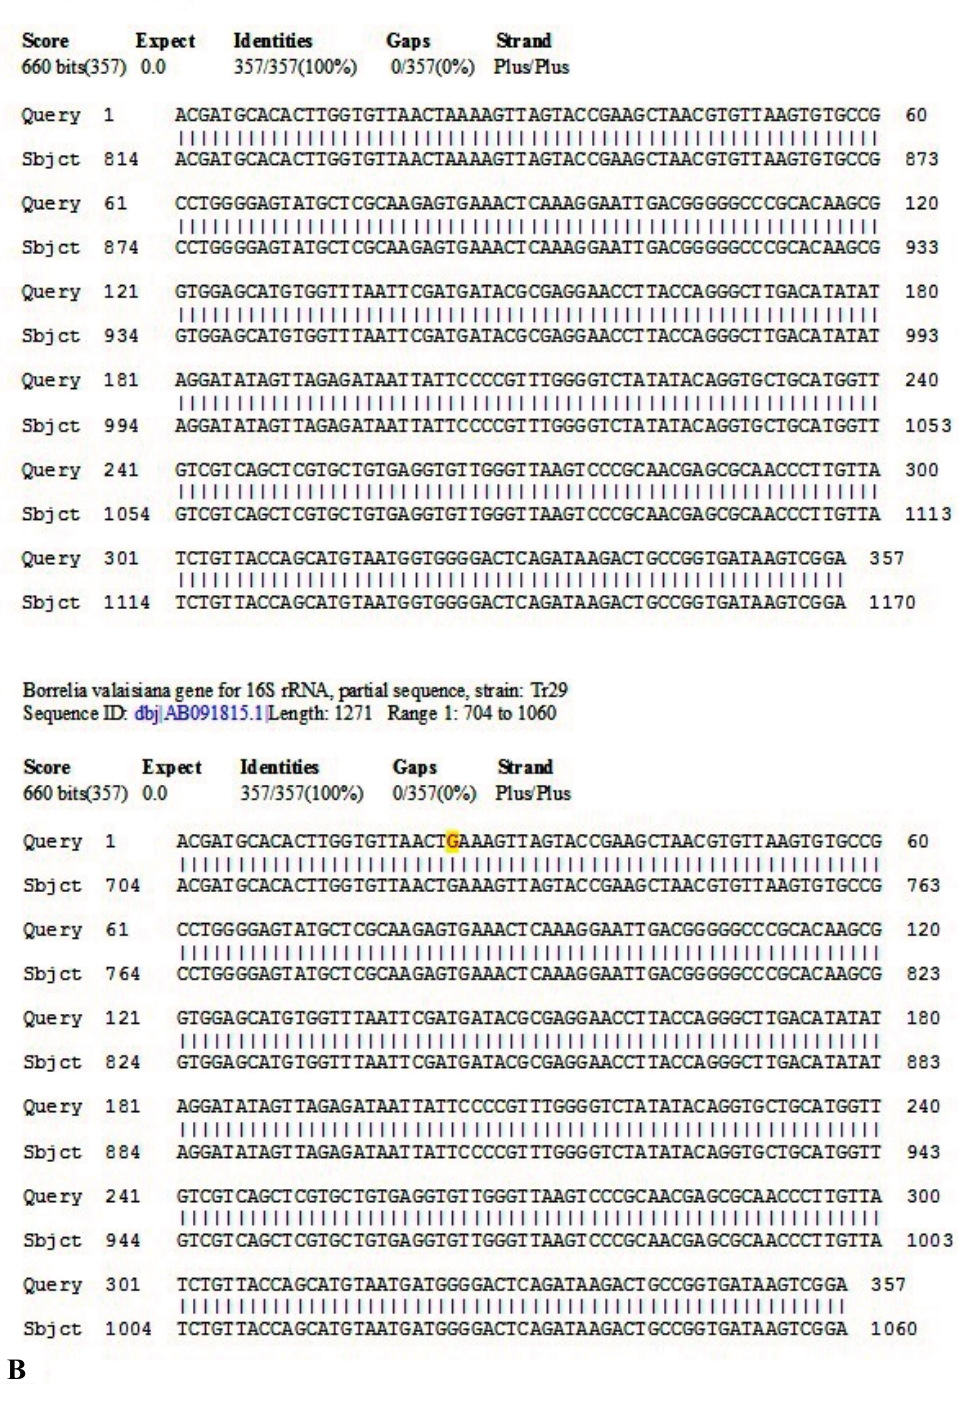
amplicon with a unique 100% ID match with the standard sequence catalogued in the GenBank provides a molecular diagnosis of a strain of B. burgdorferi sensu lato or a strain of B. miyamotoi beyond reasonable